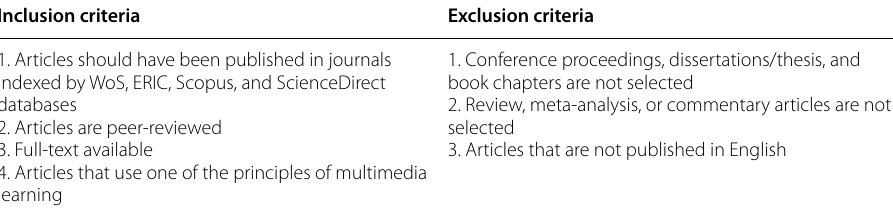
Table 2 Inclusion and exclusion criteria Inclusion criteria Exclusion